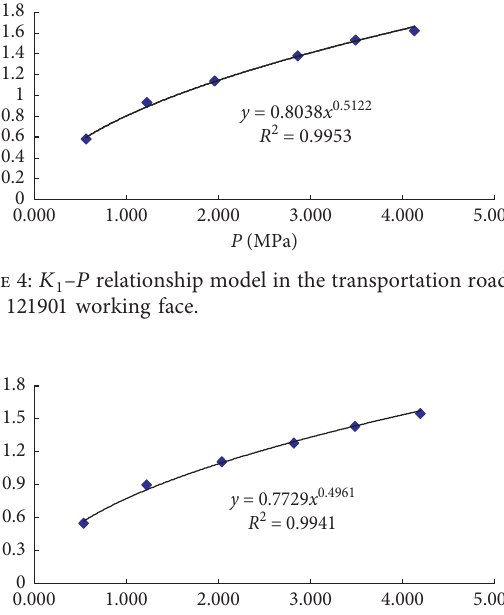
1max during the test.